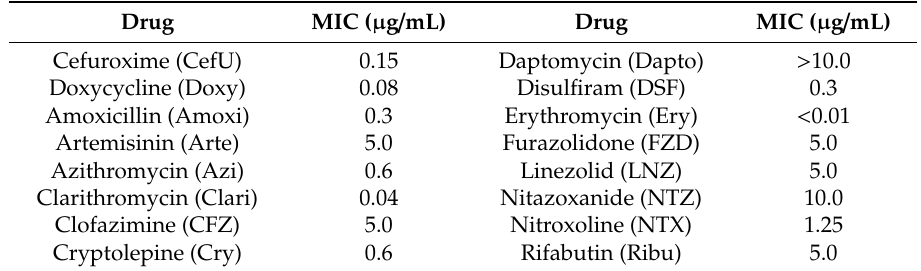
Table 1. Minimum inhibitory concentration (MIC) values. The MIC experiment was tested with the microdilution method. Drug MIC ( µ g / mL) Drug MIC ( µ g / mL) Cefuroxime (CefU) 0.15 Daptomycin (Dapto) > 10.0 Doxycycline (Doxy) 0.08 Disulfiram (DSF) 0.3 Amoxicillin (Amoxi) 0.3 Erythromycin (Ery) < 0.01 Artemisinin (Arte) 5.0 Furazolidone (FZD) 5.0 Azithromycin (Azi) 0.6 Linezolid (LNZ) 5.0 Clarithromycin (Clari) 0.04 Nitazoxanide (NTZ) 10.0 Clofazimine (CFZ) 5.0 Nitroxoline (NTX) 1.25 Cryptolepine (Cry) 0.6 Rifabutin (Ribu)